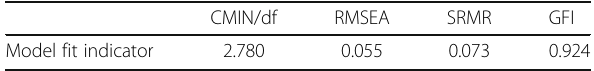
Table 3 Model fit measures of the tested model CMIN/df